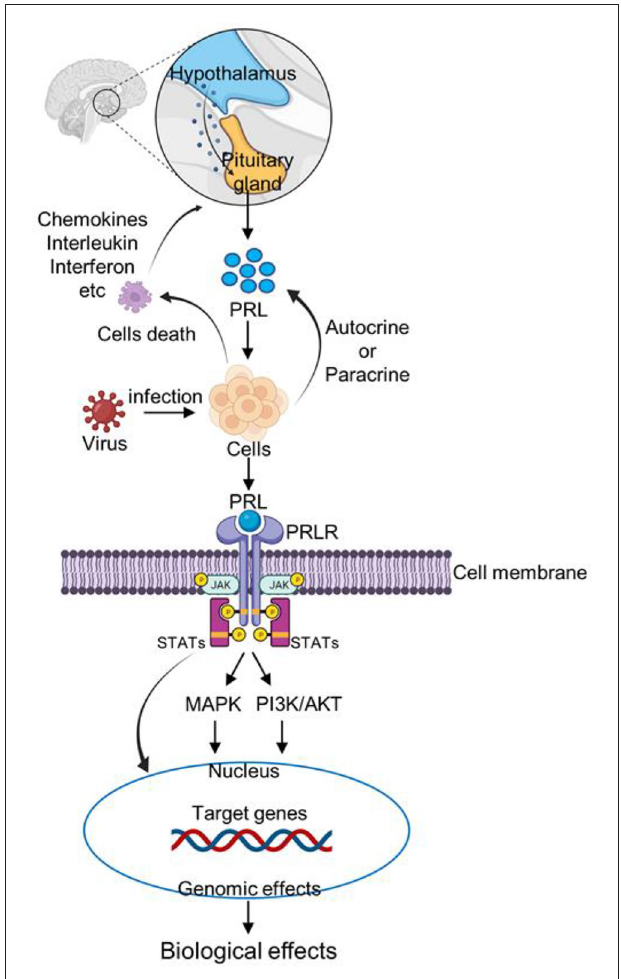
FIGURE 1 | Schematic representation of PRL signaling pathway after virus infection. After infecting host cells, the virus causes immune cells death and increase the expression of inflammatory factors, such as chemokines, interleukin, and interferon. Inflammatory factors stimulate the pituitary gland to increase PRL secretion. In addition, cells can increase PRL secretion by autocrine or paracrine pathways. Then PRL binds to the PRLR receptor on the cell membrane, and activates JAK/STAT, MAPK, and PI3K signaling pathways, thus regulating the individual immune